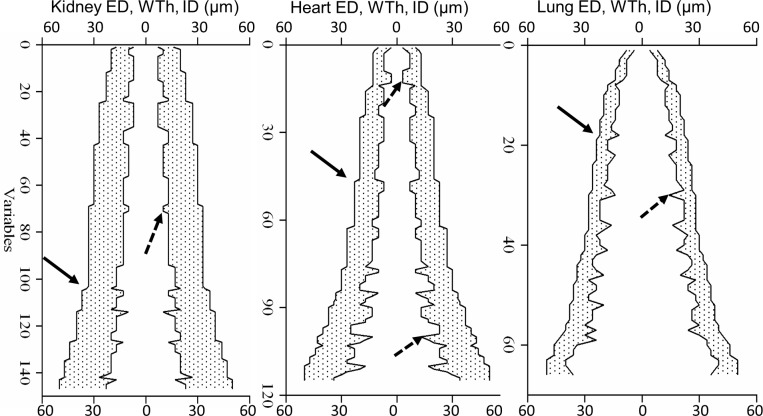
Analysis of primary data with complex profiles.Primary measurement for the kidney, heart, and pulmonary arteries were arranged in the complex profiles. Axis X–the bidirectional common scale for the external diameter (ED, outer contours), internal diameter (ID, inner contours), wall thickness (WTh, shaded regions); axis Y represents the number of measured arteries (variables) in order of ascending ED. Steps in the outer contours (solid arrows) reflected a minimal division on an eyepiece micrometer. Outliers along the internal contours (dashed arrows) corresponded to wider or narrower ID, compared to neighboring ED values.